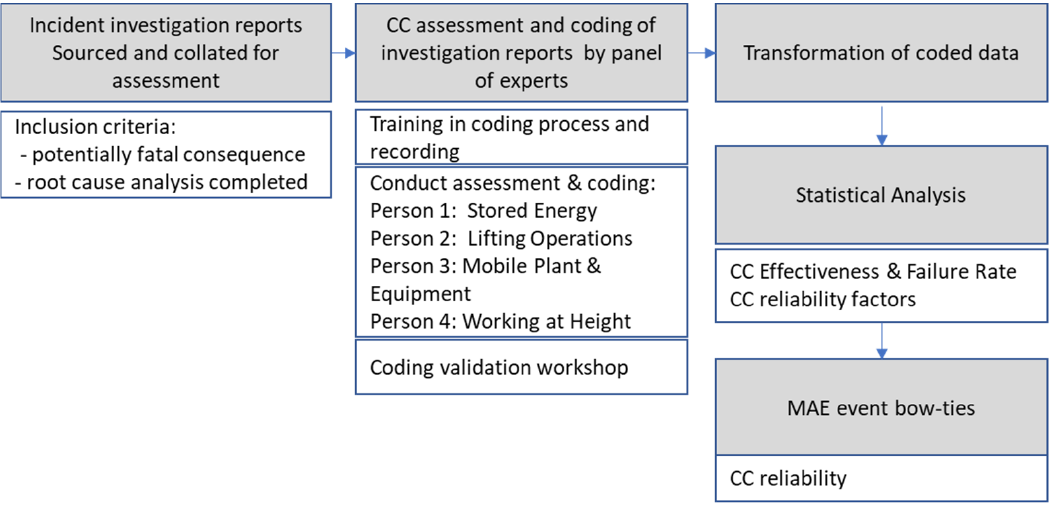
Figure 2. Research